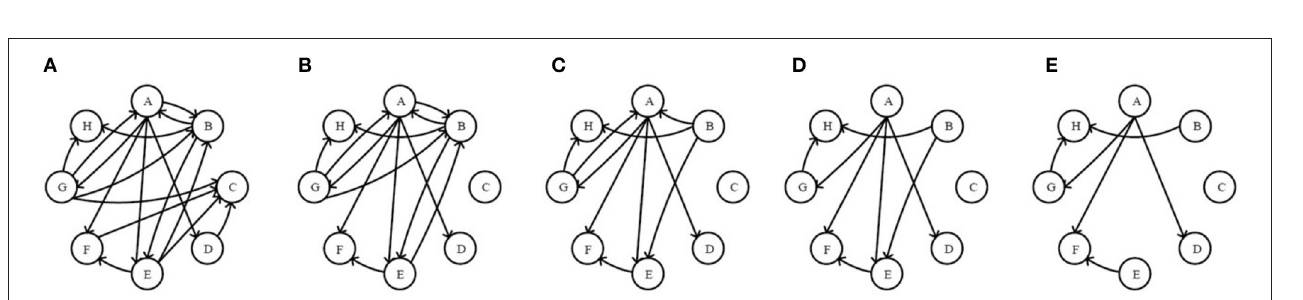
Frontiers in Neuroscience |